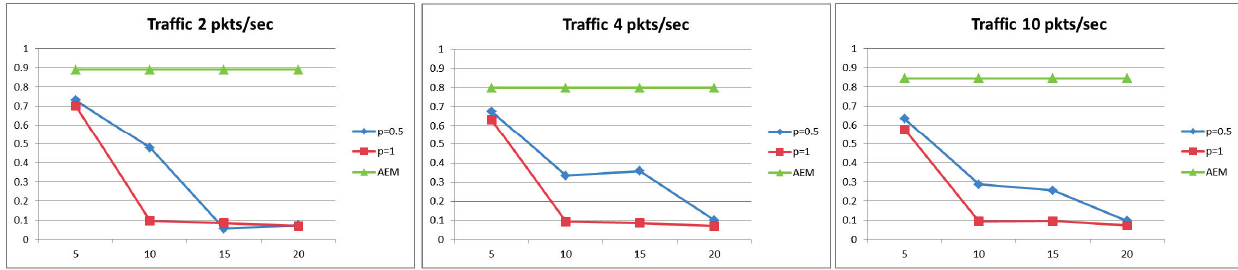
Figure 7. Information gain for D = 40